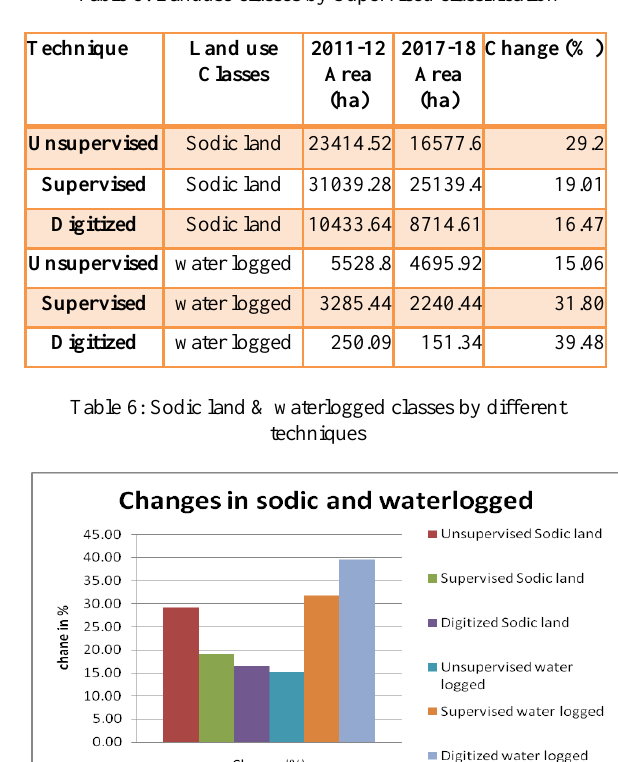
Table 5: Landuse classes by Supervised classification